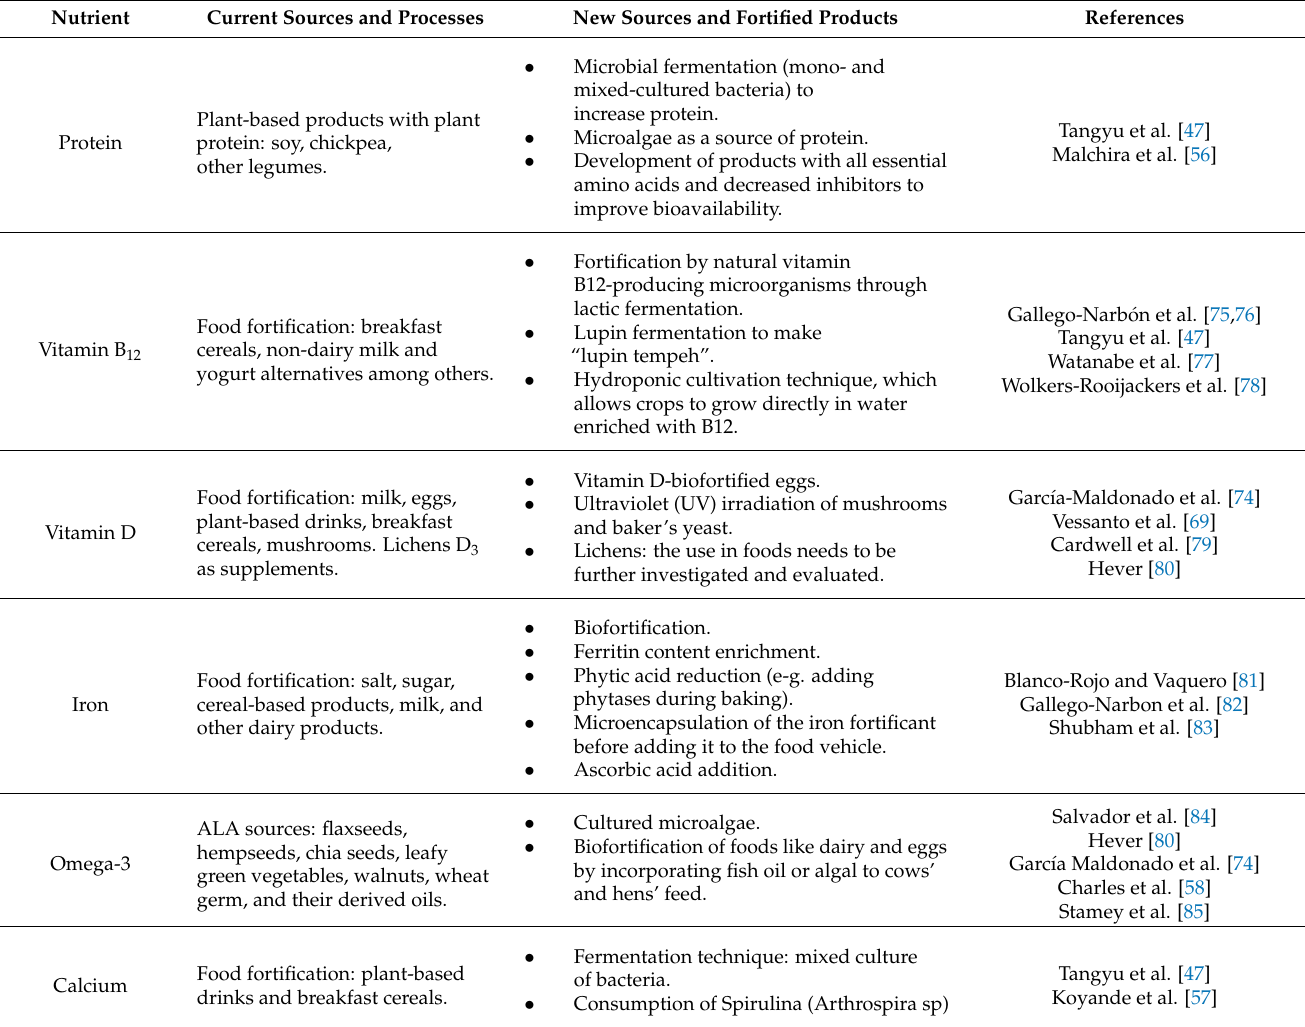
Table 2. Current vs. new nutrient fortifications in plant-based